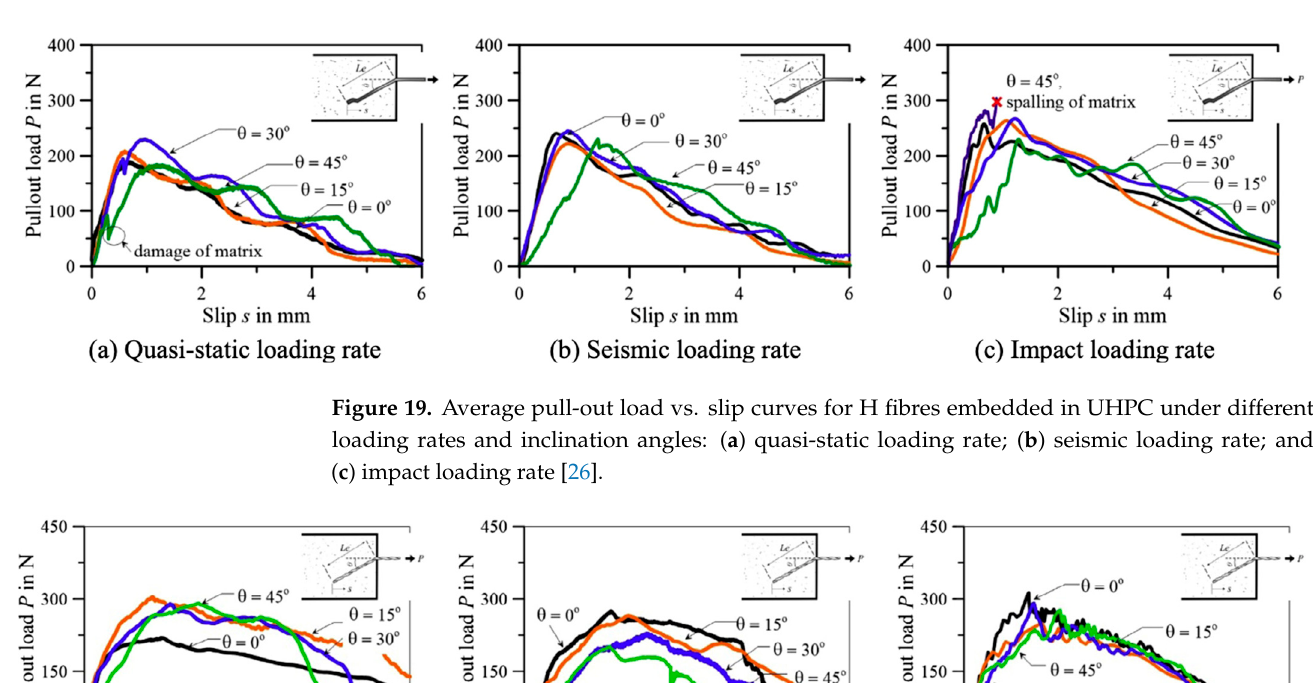
Figure 18. Average pull-out load vs. slip curves for S fibres embedded in UHPC under several load- ing rates and inclination angles: ( a ) quasi-static loading rate; ( b ) seismic loading rate; and ( c ) impact loading rate [26].